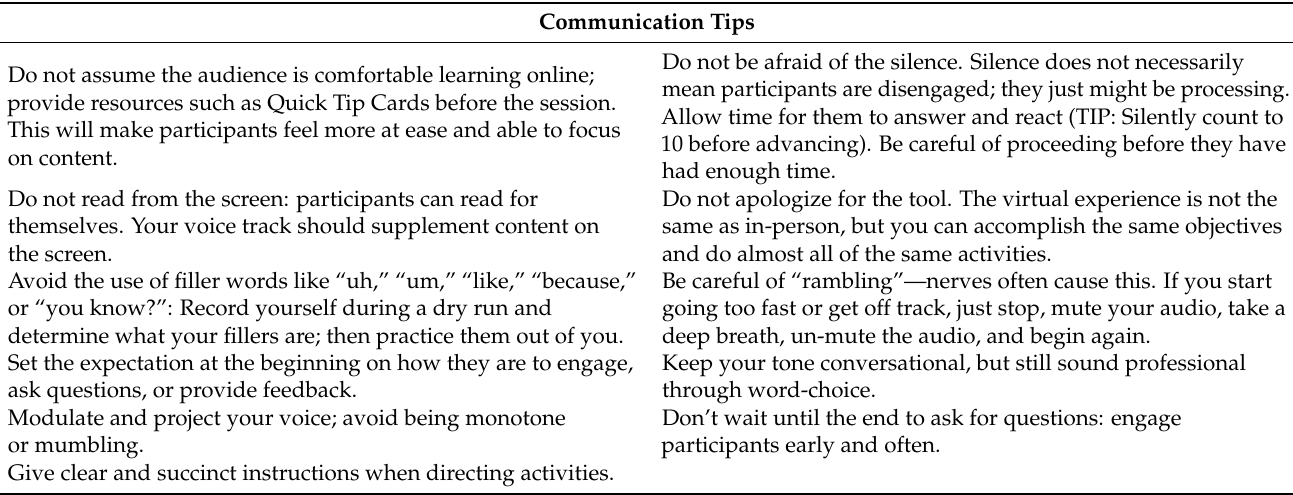
Table 5. Communication Tips During Course